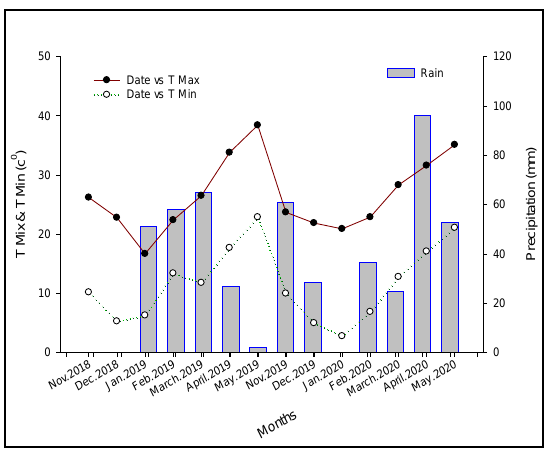
Figure 1. Average means monthly weather data of two years (2018–2019 and 2019–2020) experimental location for the crop growth season. Nov = November, Dec = December, Jan = January, Feb =